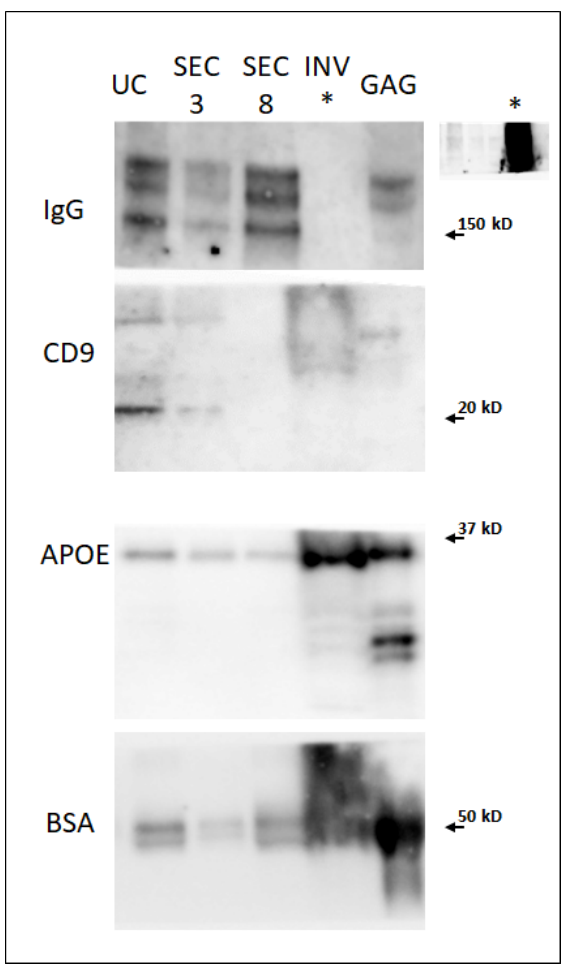
Figure 2. Western blot analysis of human EV-enriched serum preparations by using different pro- cedures (UC, ultracentrifugation, SEC3, fractions 2–4 from SEC, SEC8 fractions 7–9 from SEC, INV, Total isolation solution from Invitrogen, Invitrogen, Thermo Fisher Scientific, Waltham, MA, USA, GAG, Exo-GAG precipitation solution from Nasabiotech, A Coruña, Spain). * In the case of the sam- ple INV, it was not possible to assay the sample against IgG, due to overload of protein, as shown in the small picture of the gel at the right corner.